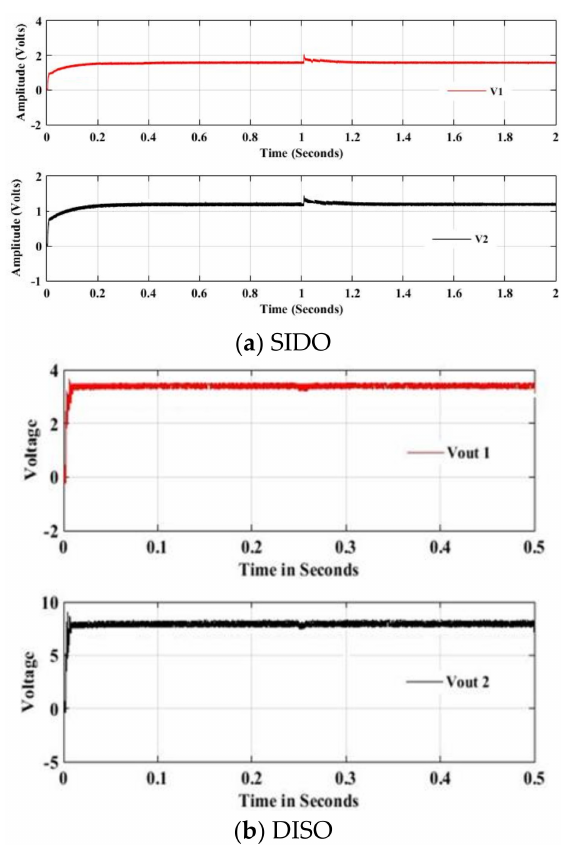
Figure 16. Output Voltages Responses from prototype model of the converters for LQR controller with load disturbances.